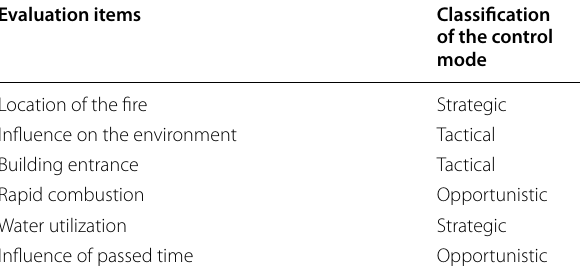
Fig.1 The weight discrimination of the evaluation items in the reconnaissance activity